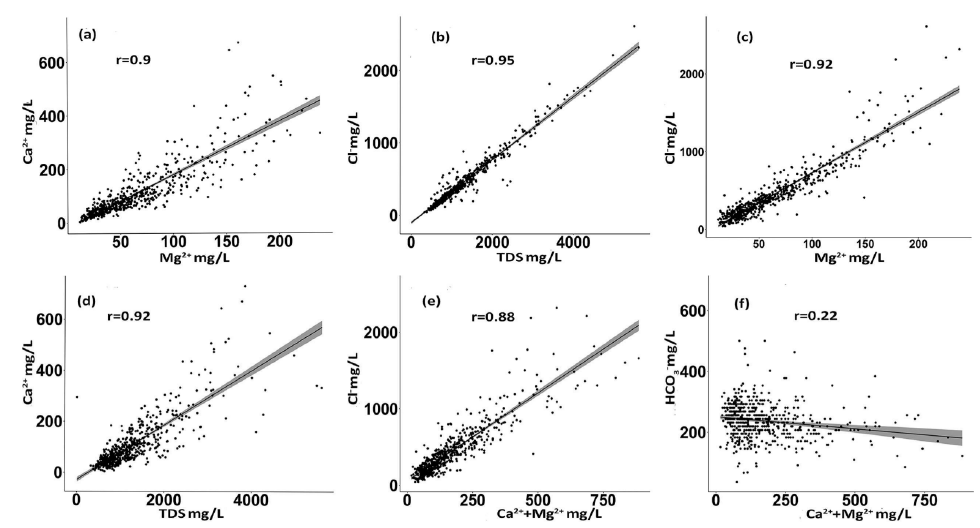
Figure 3. Bivariate plots of the most significant parameters of groundwater samples in the study area, ( a ) Mg 2+ vs. Ca 2+ , ( b ) TDS vs. Cl − , ( c ) Mg 2+ vs. Cl − , ( d ) TDS vs Ca 2+ , ( e ) Ca 2+ vs. Cl − , ( f ) Ca 2+ + Mg 2+ vs. HCO 3 −